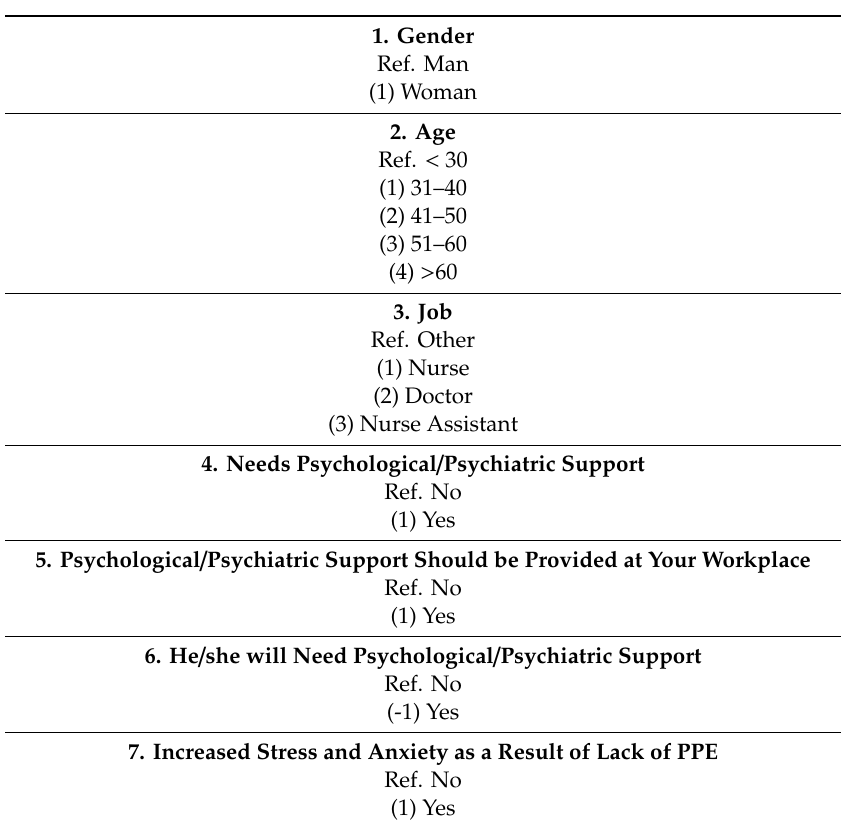
Table 2. Variables used in binary logistic